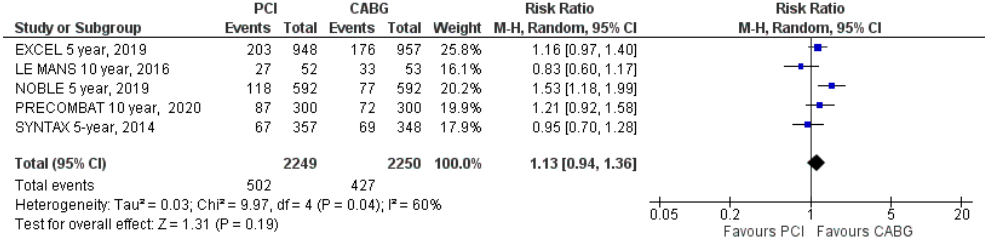
Figure 2. Risk of major adverse cardiac events (MACE) at the latest follow-up: PCI vs. CABG.